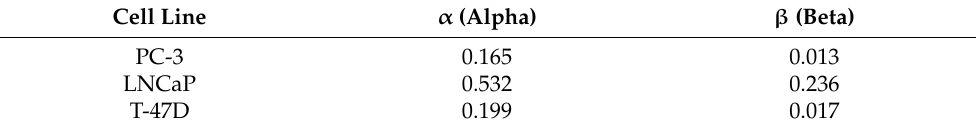
Table 1. Coefficients obtained from the linear quadratic curve fitting to measured